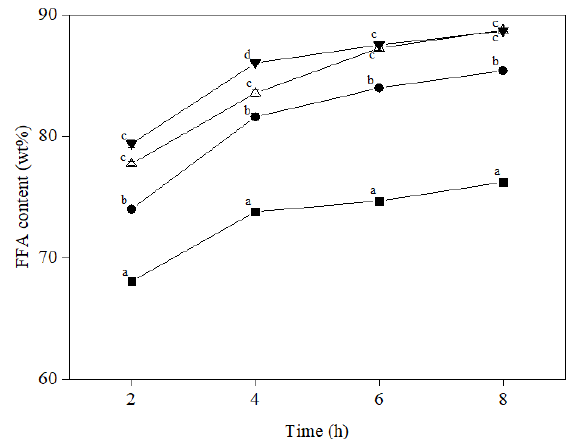
Figure 3. Effect of the buffer solution percentage ( 25 wt%, 50 wt%, 75 wt% and 100 wt% based on the oil mass) on the FFA content (hydrolysis carried out at 55 °C, stirring rate of 400 rpm, and 10 wt% Lipozyme® RM IM). Means followed by the same letter, for the same reaction time, do not statistically differ